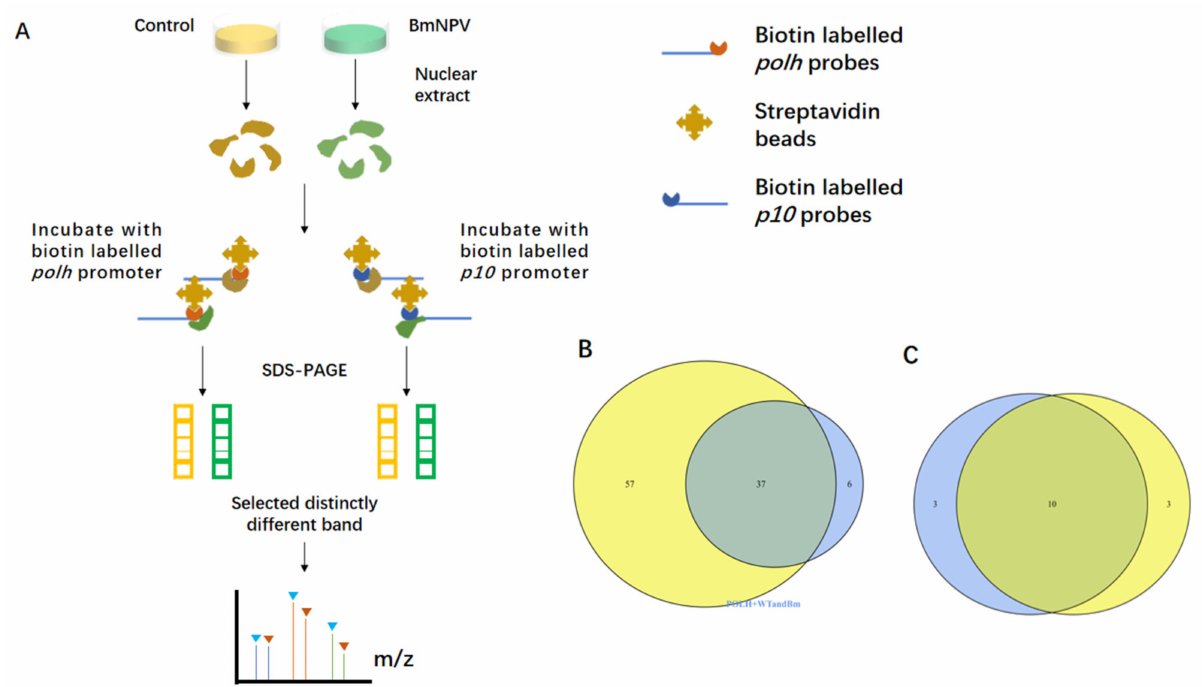
Figure 1. MS analysis of the binding proteins to the polh and p10 promoter. ( A ) Schematic of our approach. ( B ) Venn diagram displaying the summary statistics of the host proteins bound to polh promoter and p10 promoter. Total proteins identified in polh are indicated by a blue circle and proteins identified in p10 are indicated by a yellow circle. ( C ) As in ( B ), summary statistics of the viral proteins bound to polh promoter and p10